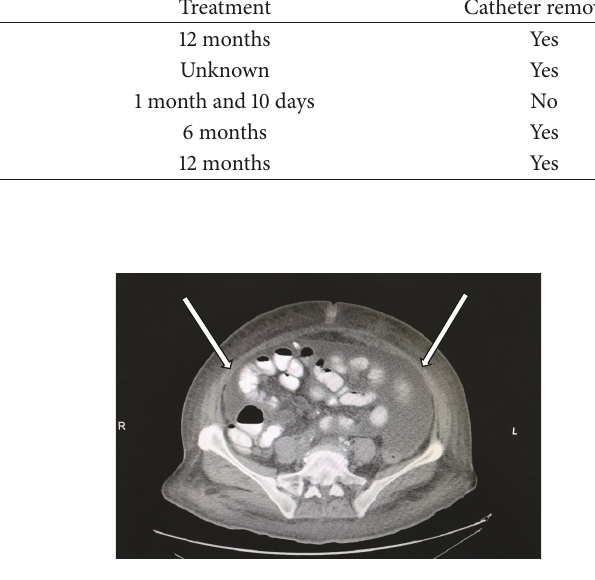
Figure 1: Computed tomography of the abdomen showing peri- toneal thickening (arrows), consistent with